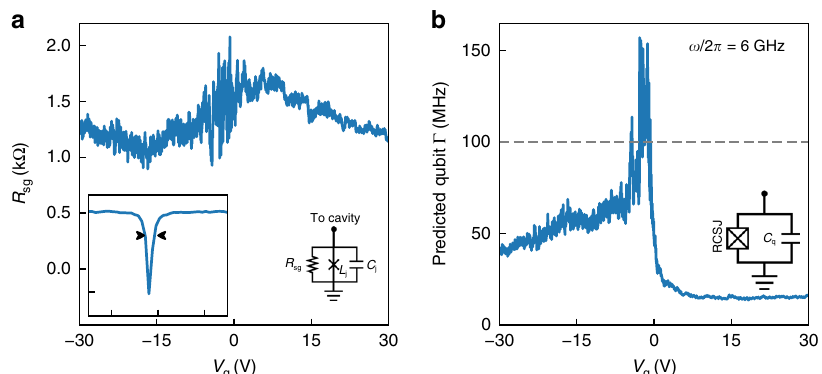
Fig. 4 Subgap resistance from microwave cavity measurements. a Extracted sub-gap resistance at as a function of gate voltage. The values are calculated by calibrating the cavity properties and using the junction model shown connected to the transmission line cavity to fi t the observed cavity response. Inset shows the cavity response at V g = 30 V. The horizontal and vertical axis divisions are 10 MHz and 10 dB respectively. b Predicted linewidth for a graphene transmon qubit, obtained by taking the RCSJ parameters as a function of gate and adding a capacitance C q such that the fi nal operating frequency remains q(cid:5) (cid:6) ffiffiffiffiffiffiffiffiffiffiffiffiffiffiffiffiffiffiffiffiffiffiffiffiffiffi (cid:2) 1 ω = 2 π = 2 π ð L ð C þ C ÞÞ = 6 GHz . We assume the internal junction losses dominate the total linewidth. The horizontal line represents the j j q anharmonicity of a typical SIS transmon E c / h = 100 MHz. In regions where the blue line falls under the dashed line, a gJJ transmon would be capable of operating as a qubit. The error bands for both panels can be found in Supplementary Fig.